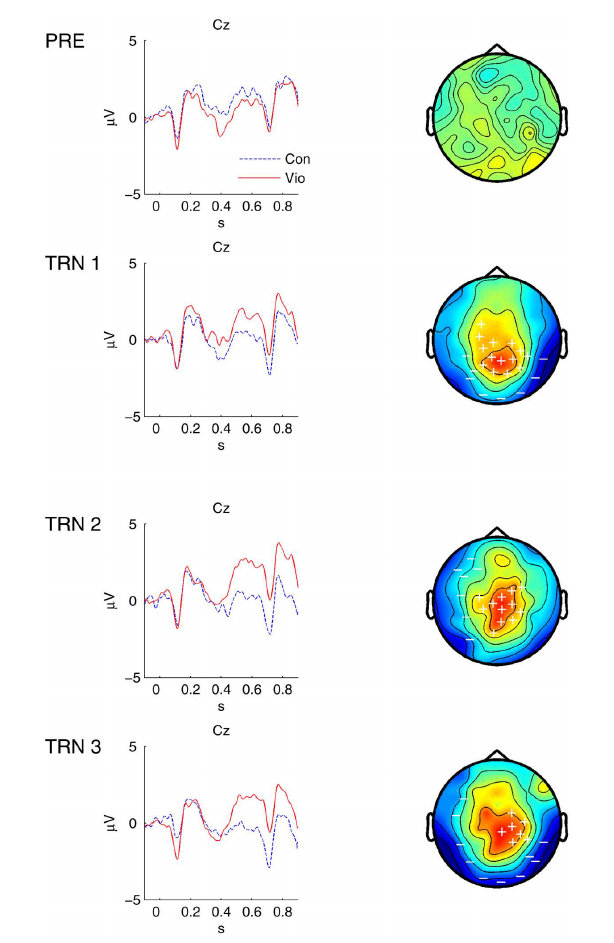
FIGURE 5 |Average event-related potentials for gender violation contrast (3 word). Trace plots indicate average voltage (in μ V) as a function of time at Cz/1; control = Con (blue, dotted line), violation = Vio (red, solid line).There were no statistically significant clusters.Topographical plots are viewed from the top (left is on the left-hand